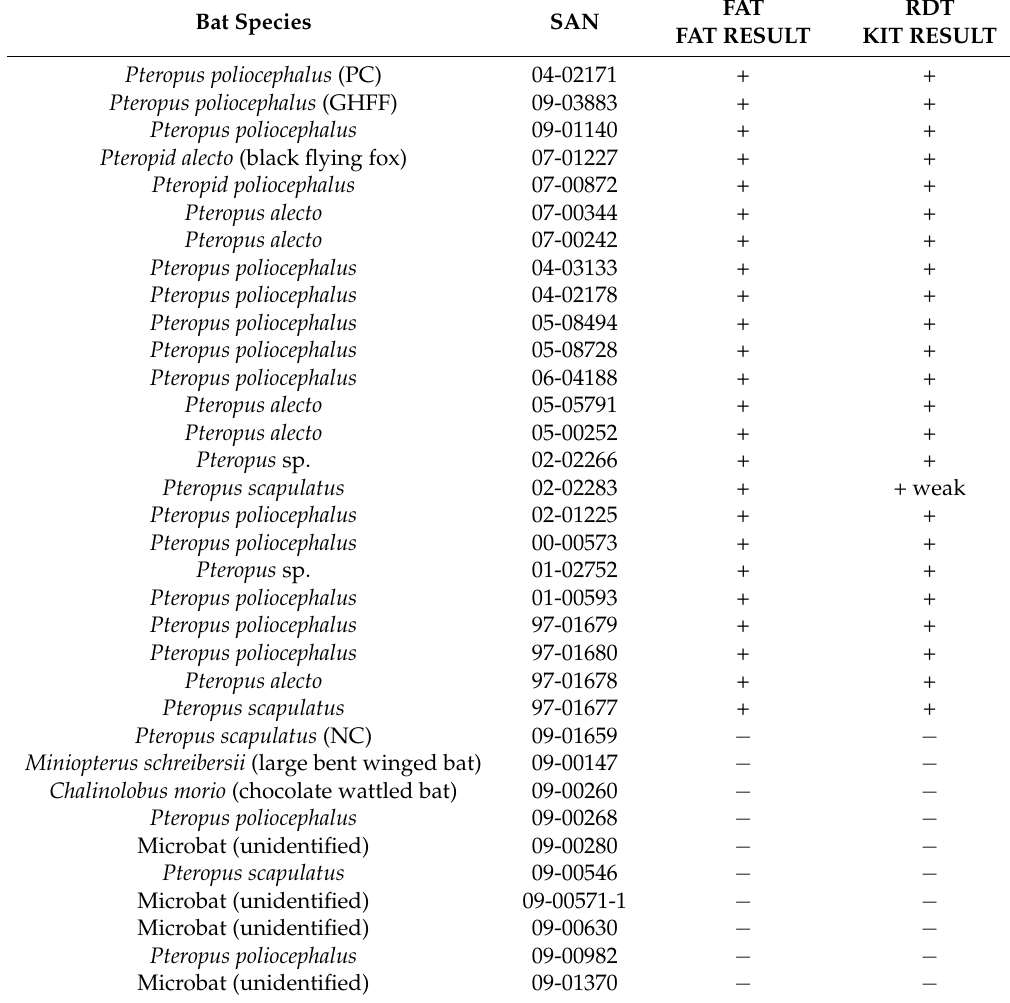
Table 1. Comparison of the Anigen Rapid Rabies Ag Test Kit (RDT) with the reference standard fluorescent antibody test (FAT) using clinical specimens derived from brain tissues of Australian pteropodid